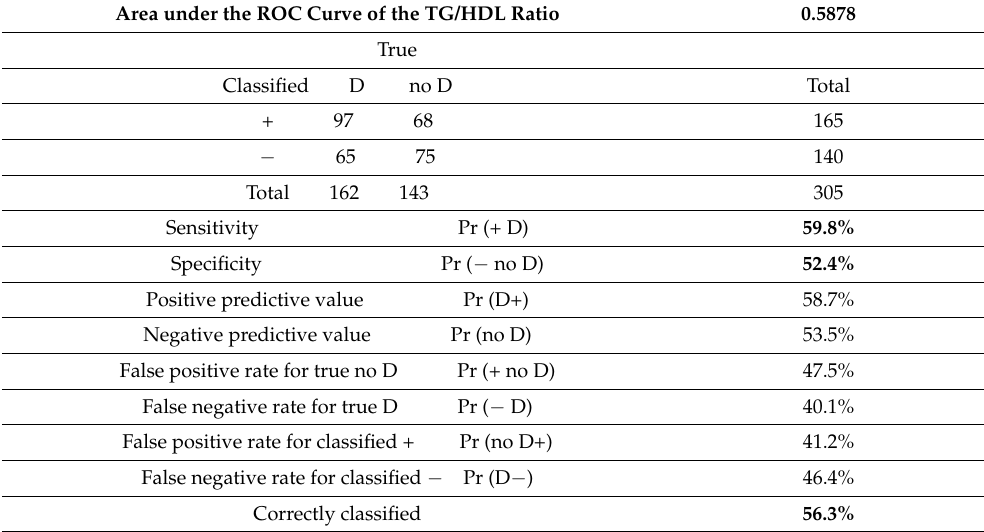
Table 4. Statistical details concerning the performance of the triglycerides/HDL ratio in ascertaining the presence of bladder cancer.